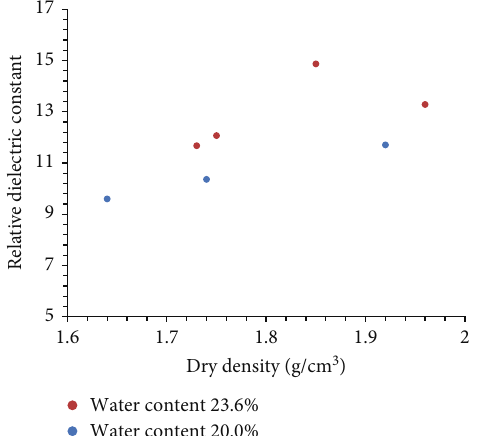
Figure 13: The relative dielectric permittivity values of samples changing with di ff erent compaction levels and the same water content under di ff erent